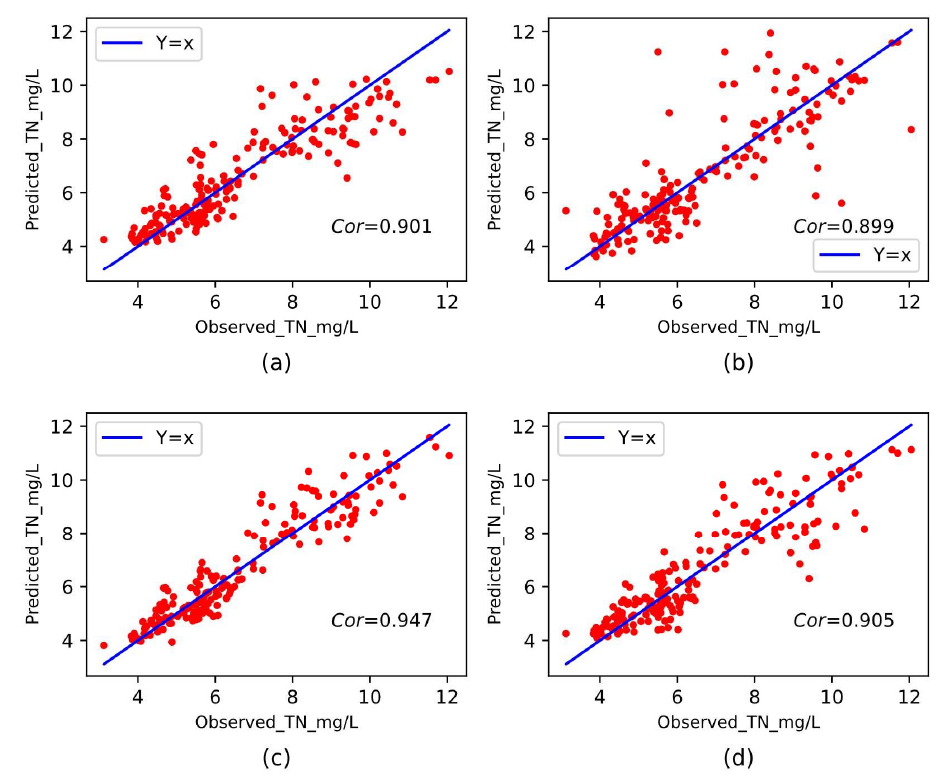
Figure 5. Cor for non-ensemble learning methods: ( a ) SVR. ( b ) KNN.( c ) MLP. ( d ) Ridge